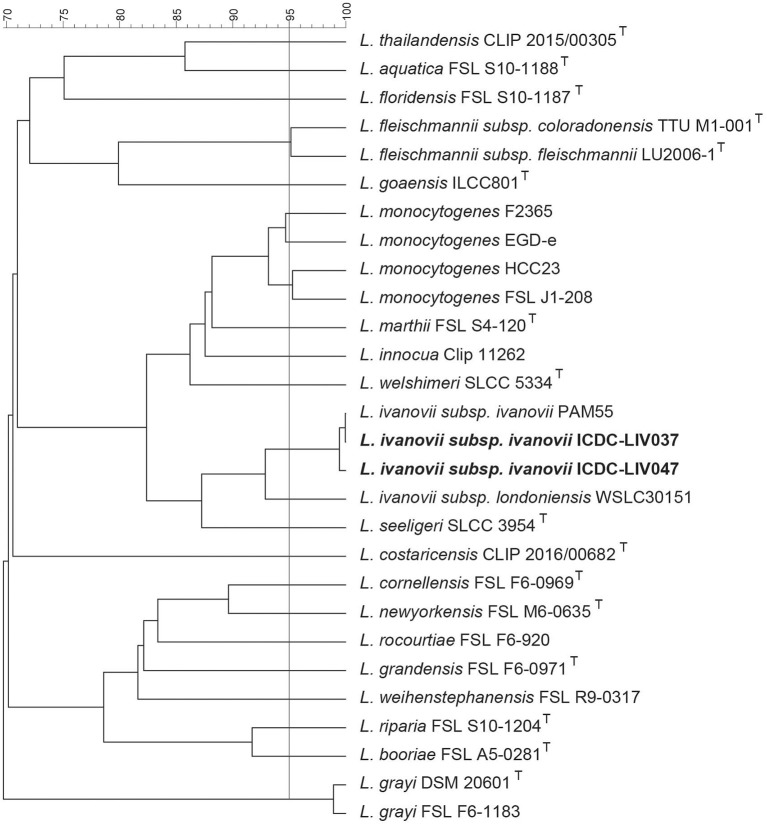
The dendrogram of UPGMA clustering based on ANI. The 20 species of Listeria including L. ivanovii were used to construct the dendrogram. The vertical bar represents the 95% ANIb that correlates with the 70% DNA-DNA hybridization threshold (30). The reference strain PAM55, ST1 strain LIV037, and ST2 strain LIV047 were formed an independent clade respectively, and the ANI between them were larger than 99%.